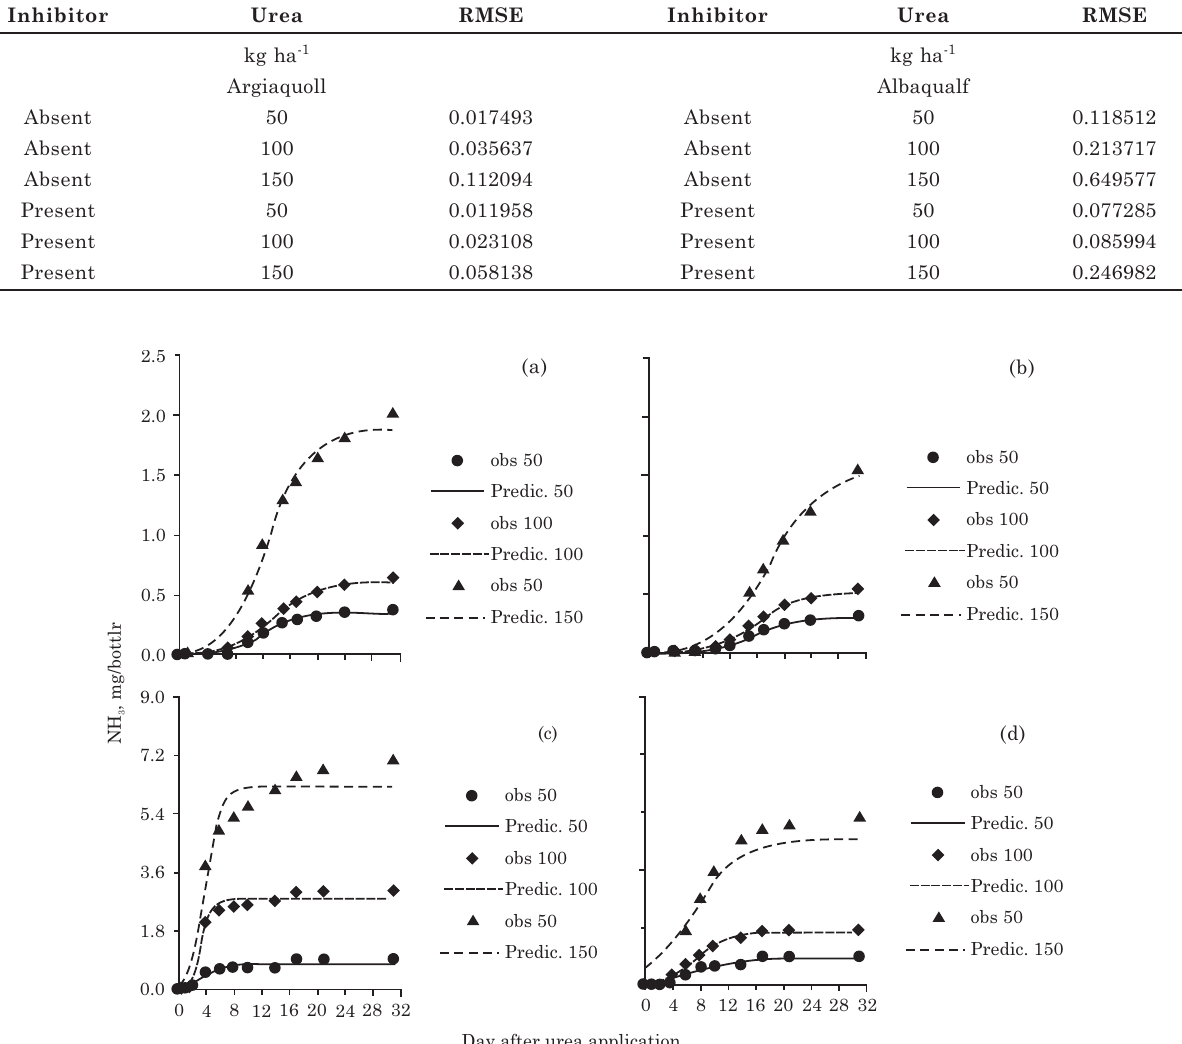
Table 4. Wilk’s Lambda statistic and the probability “p” of the approximate F statistic for the hypothesis tests by MANOVA